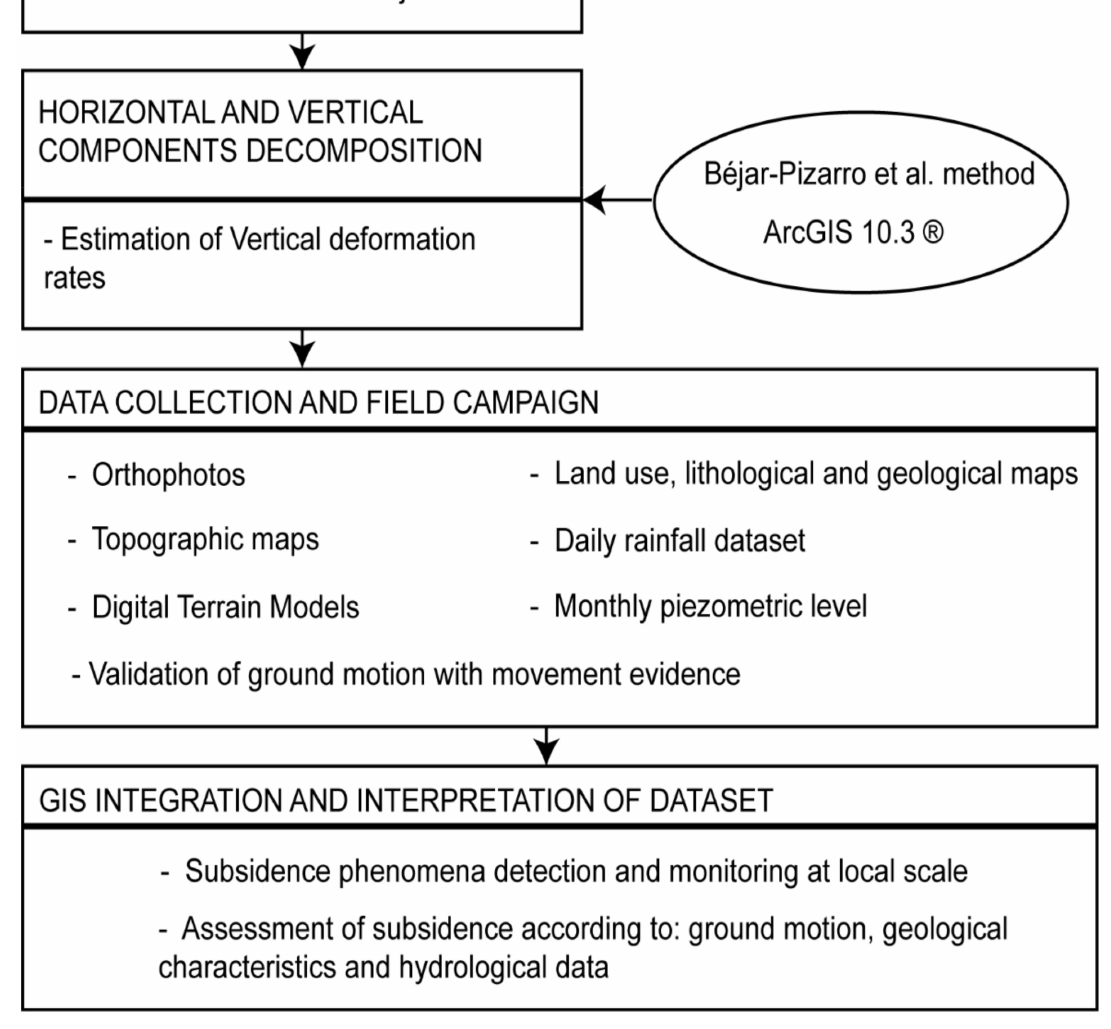
Figure 2. Flow diagram of the procedure used in this